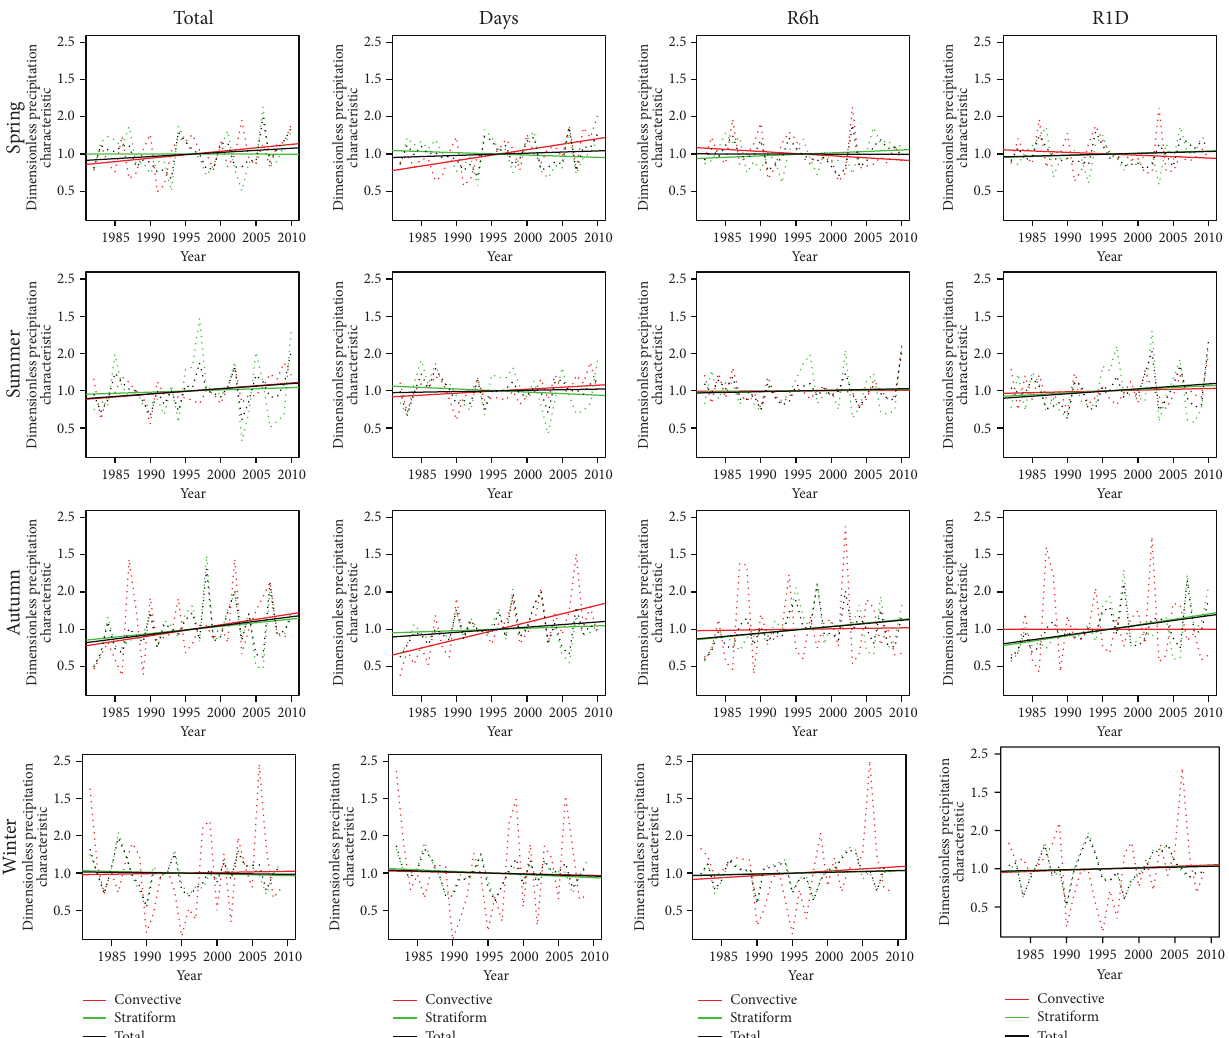
Figure 2: Time series and trend magnitudes obtained by the linear regression for convective, stratiform, and total precipitation characteristics averaged over 11 stations in the Czech